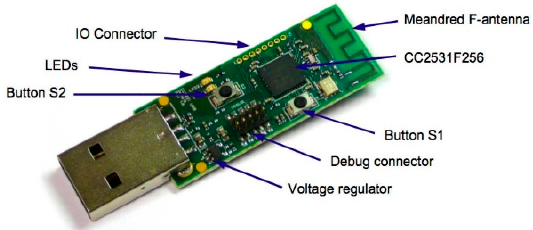
Figure 16. CC2531 USB Dongle [Source: TI.com].